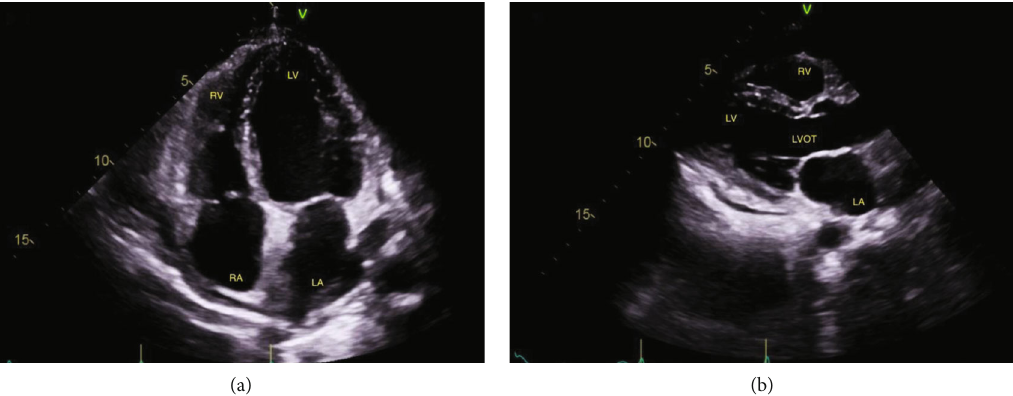
Figure 5: Transthoracic echocardiogram 4 weeks since admission. The left ventricle has normal size. LVEF is 55-60%. LV strain is -19%. The right ventricle free wall is thick, and mitral valve lea fl ets are thickened. Small-to-moderate circumferential pericardial e ff usion. There is no evidence of tamponade. (a) Apical 4-chamber view and (b) parasternal long-axis